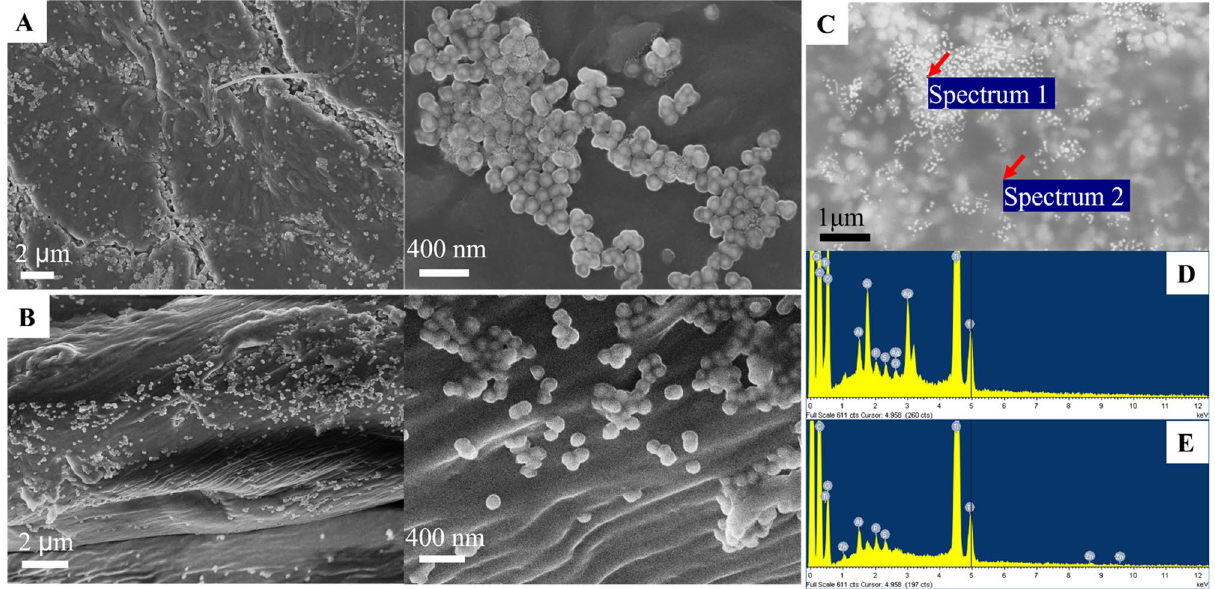
Figure 3. Scanning Electron Microscopy (SEM) and elemental analysis (EDX) of the materials labelled with AgNPs@MBA@SiO 2 . SEM images of leather ( A ) or cotton ( B ) labelled with AgNPs@MBA@SiO 2 showing their distribution within the substrate depending on their characteristics ( C ) SEM image of ( A ) showing areas with (spectrum 1) and without (spectrum 2) visible NPs that were selected for elemental analysis. ( D , E ) Their corresponding spectra. The peaks from left to right in ( D, spectrum 1 ) correspond to: Cl, C, Ti, O, Al, Si, P, S, Ag/Cl, Ag, Ti, Ti, and in ( E, spectrum 2 ) to: C, Ti, O, Zn, Al, P, S, Ti,